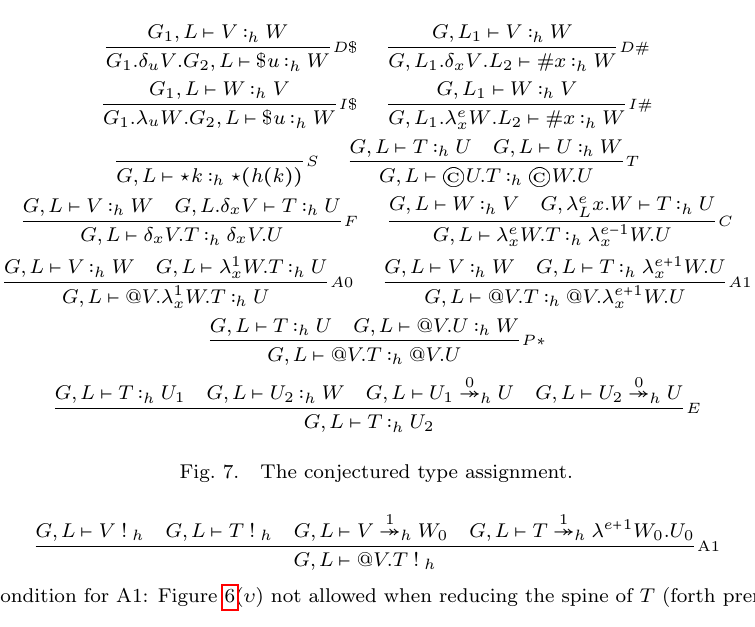
Fig. 8. The proposed restricted applicability